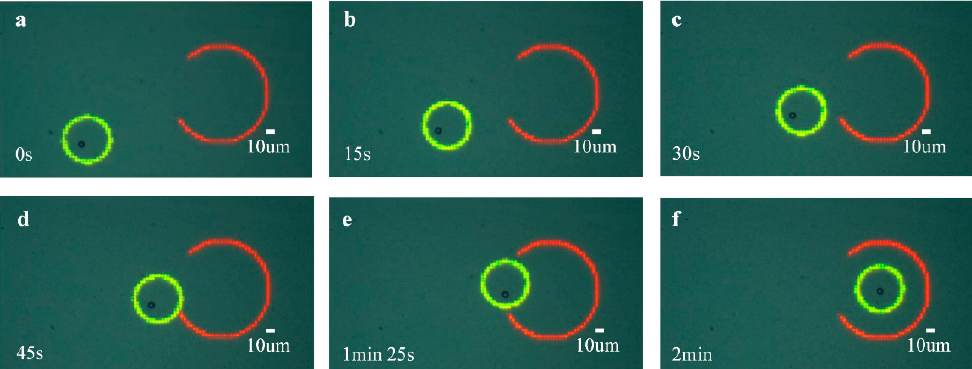
Figure 8. Diagrams of the manipulation process. The center of the red arc is the target position and the notch of the arc is the entrance of the optical pattern; The green circle is an annular optical pattern. ( a – f ) are the real-time status of automatic manipulation in chronological order.